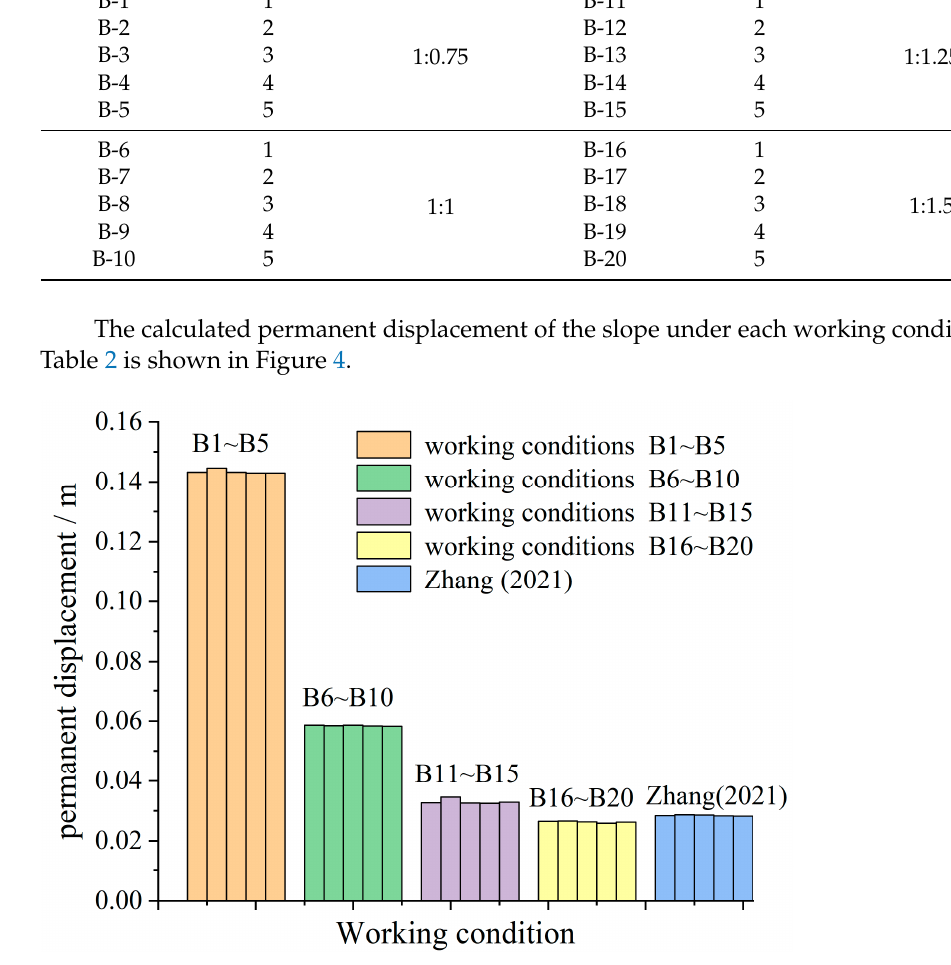
Table 2. Working conditions for calculation of the number of stage changes in multi-stage loess slope. Comprehensive Working Slope Stage Slope Rate Condition